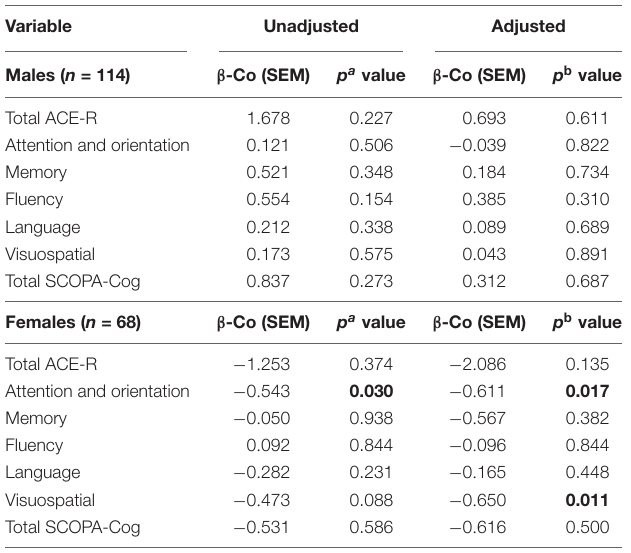
TABLE 2 | Cognitive performance in participants based on TC levels, when separated by sex.